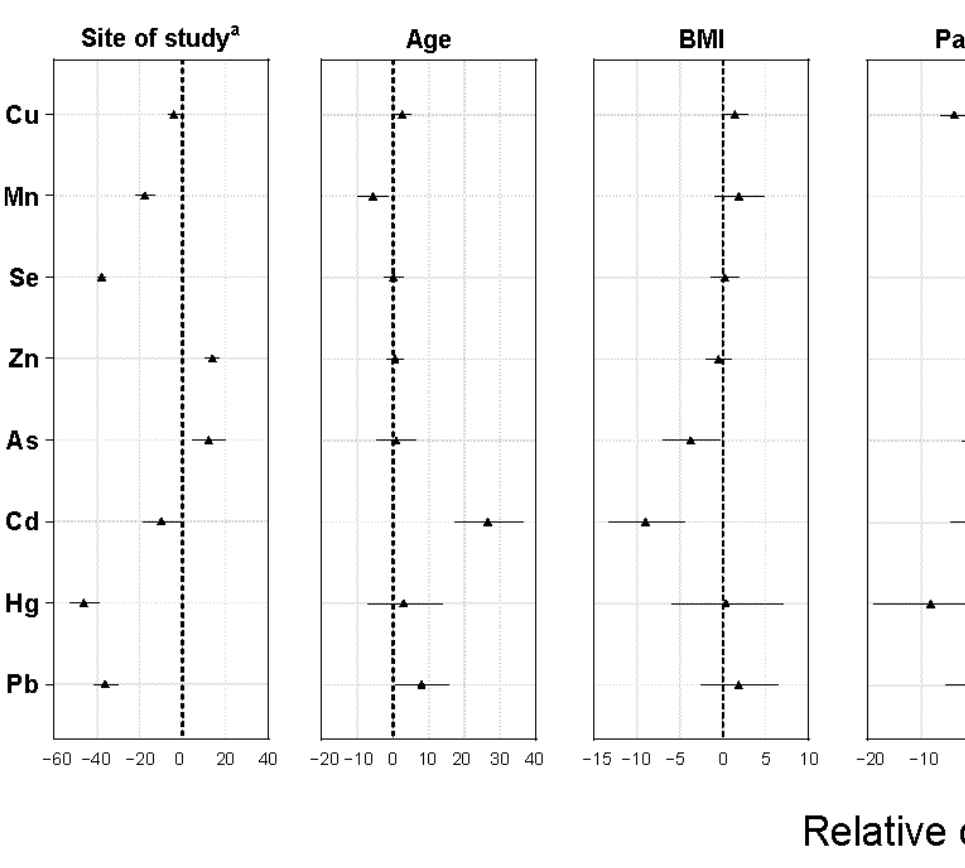
Figure 1. Relative change (%) in geometric mean of maternal whole blood concentrations (µg/L) of essential and toxic elements by unit change calculated from coefficients β and standard errors of the multiple linear regression analyses described in Supplementary Materials, Table S2. The unit of change for each variable was set as interquartile range. a Salta as reference site (Salta vs. Ushuaia); b para 1 as reference category (para 1 vs. parous); c non-smokers as reference (non-smoker vs. smoker); d the highest education level is primary or secondary as the reference group (primary/secondary education vs. tertiary/university); and e urban dweller as reference category (urban vs. semi-urban and rural). Abbreviations: As, arsenic; BMI, body mass index; Cd, cadmium; Cu, copper; Hg, mercury; Mn, manganese; Pb, lead; Se, selenium; and Zn, zinc.